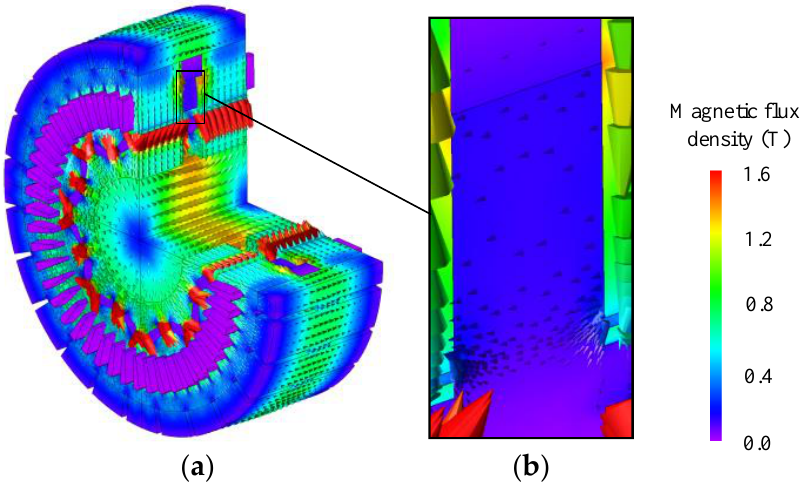
Figure 3. Vector plot of modulation flux with F m of 1200 AT: ( a ) modulation flux; ( b ) leakage modulation flux passing through air.